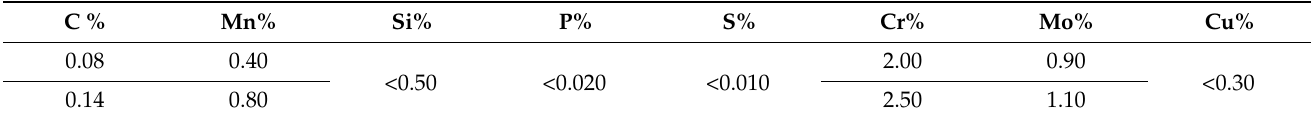
Table 1. Chemical composition of 10CrMo9-10